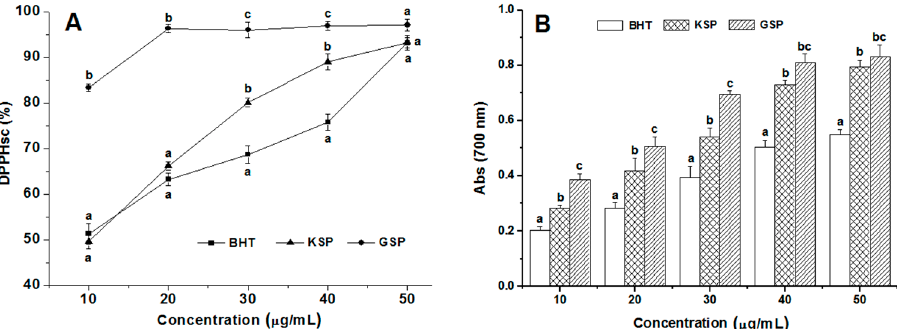
Figure 3. DPPH free radical scavenging ( A ) and ferric reducing antioxidant power ( B ) effects of the KSP in comparison with grape seed polyphenols (GSP) and butyl hydroxy toluene (BHT). Bar with the different letters represent values that significantly different according to the Duncan’s